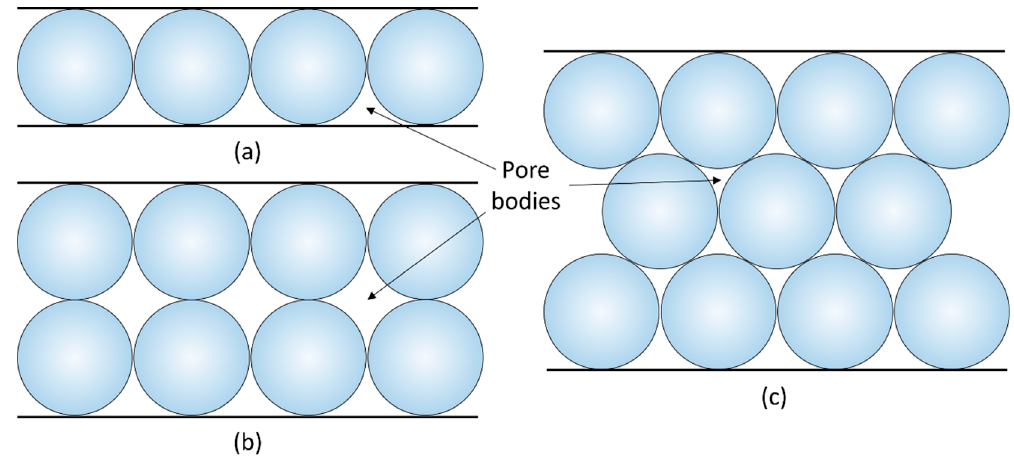
Figure 5. Cross-section of pores in the glass-bead models containing: ( a ) single layer of identical spheres, ( b ) multi-layer cubical packaging of identical beads, and ( c ) multi-layer hexagonal packaging of identical beads.